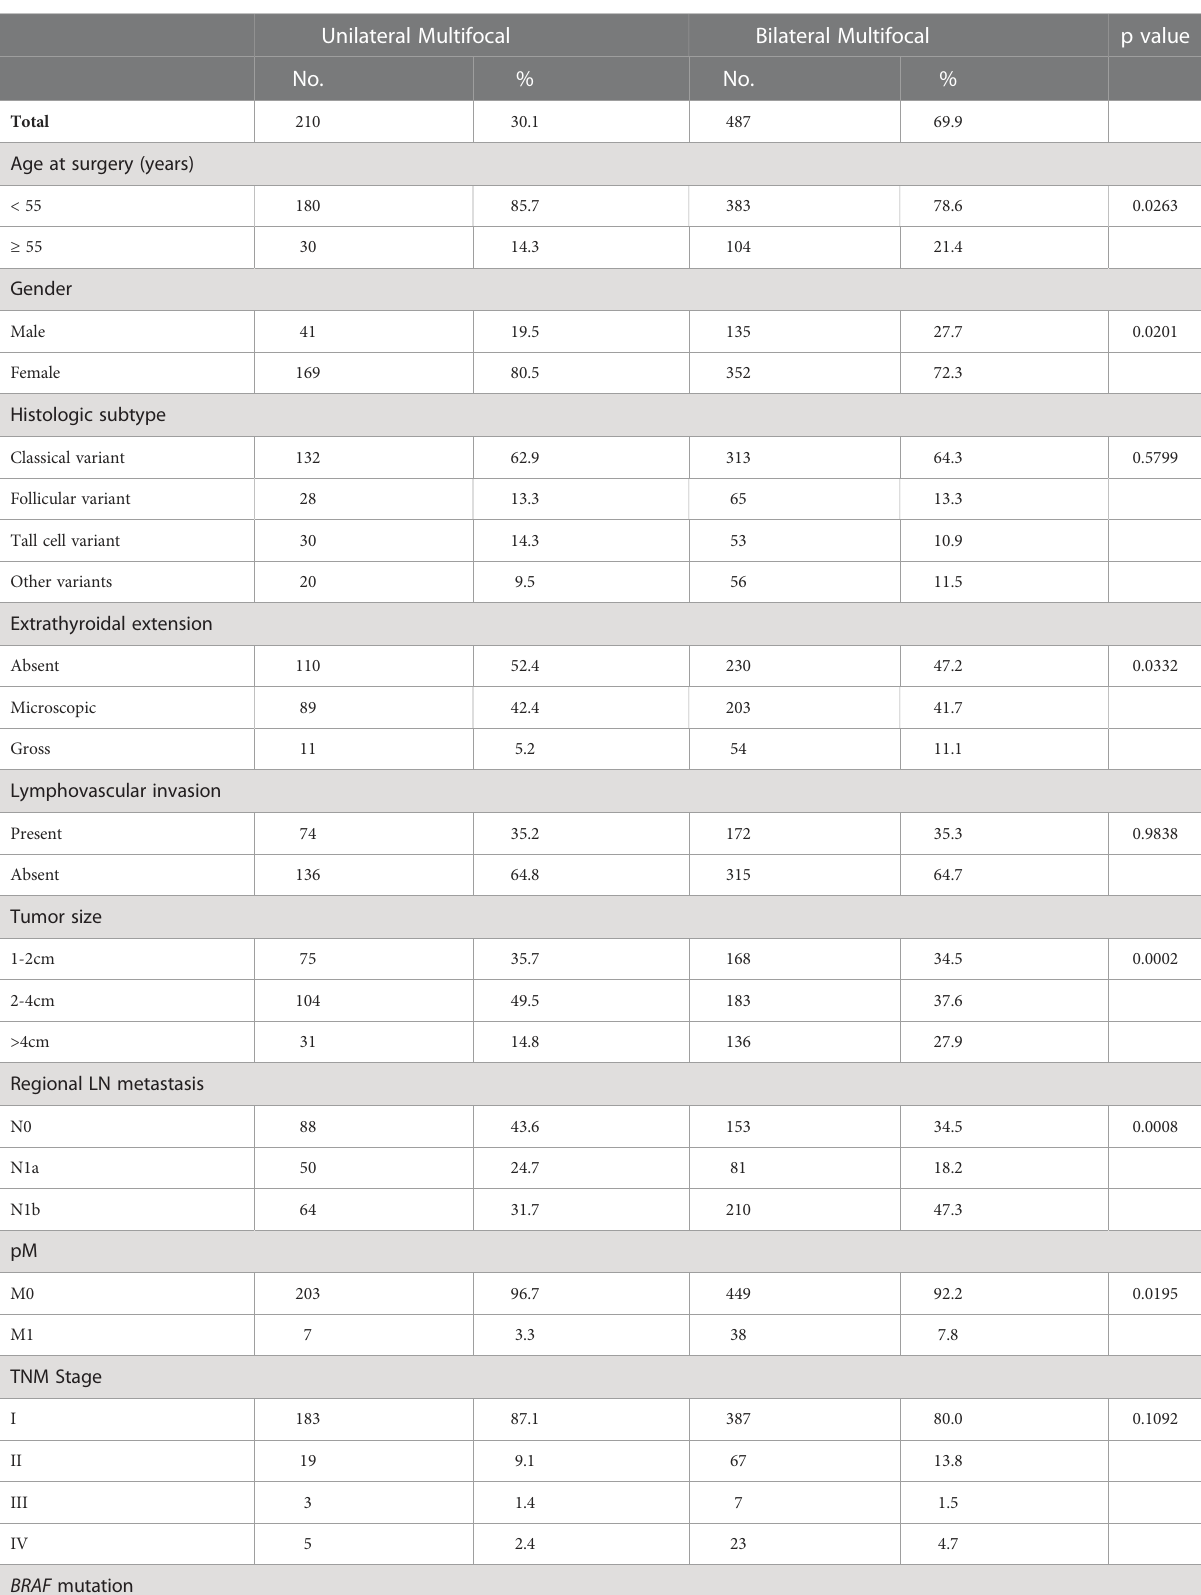
TABLE 2 Clinico-pathological associations of unilateral and bilateral multifocal papillary thyroid carcinomas. Unilateral